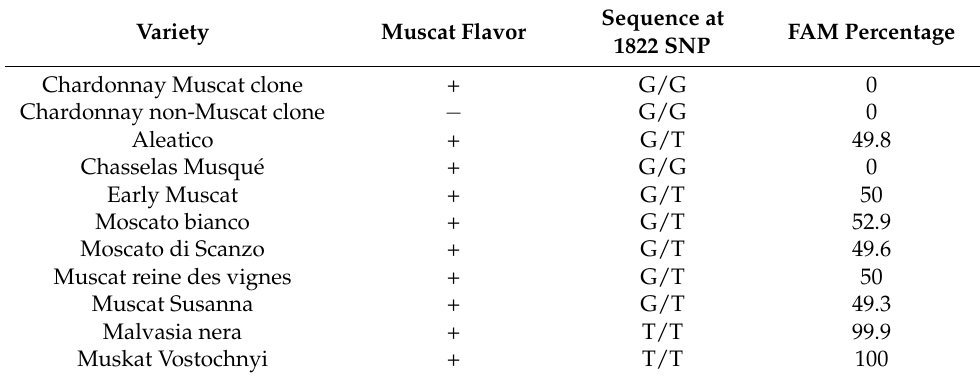
Table 1. Varietal names, Muscat flavor (according to [10]), the 1822 SNP sequences at the VvDXS gene, and dPCR data obtained expressed as a percentage of FAM copies/ µ L on the total (FAM + VIC) copies/ µ